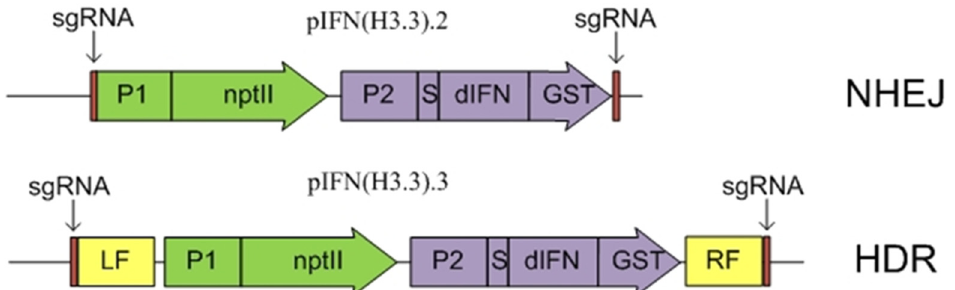
Figure 2. Diagrams of genetic constructs for delivery of the dIFN gene to the region of the histone H3.3 gene. Designations: LF and RF, left and right flanking sequences homologous to the corresponding regions in the A. thaliana genome (intergenic region before the H3.3 histone gene); P1-P-NOS promoter of Agrobacterium tumefaciens nopaline synthase; P2, CaMV35S promoter of the cauliflower mosaic virus; nptII, neomycin phosphotransferase II gene providing plant cell resistance to kanamycin; S, is the DNA sequence encoding the leader signal of the carrot extensin gene, which ensures the transport of deltaferon into the apoplast; dIFN, DNA sequence encoding the target dIFN protein; GST, DNA sequence encoding a tag for protein affinity purification; sgRNA—Cas9 endonuclease recognition sites identical to the recognition site in the intergenic region upstream of the A. thaliana histone H3.3 gene, for excision of the construct from the plasmid in the cell.